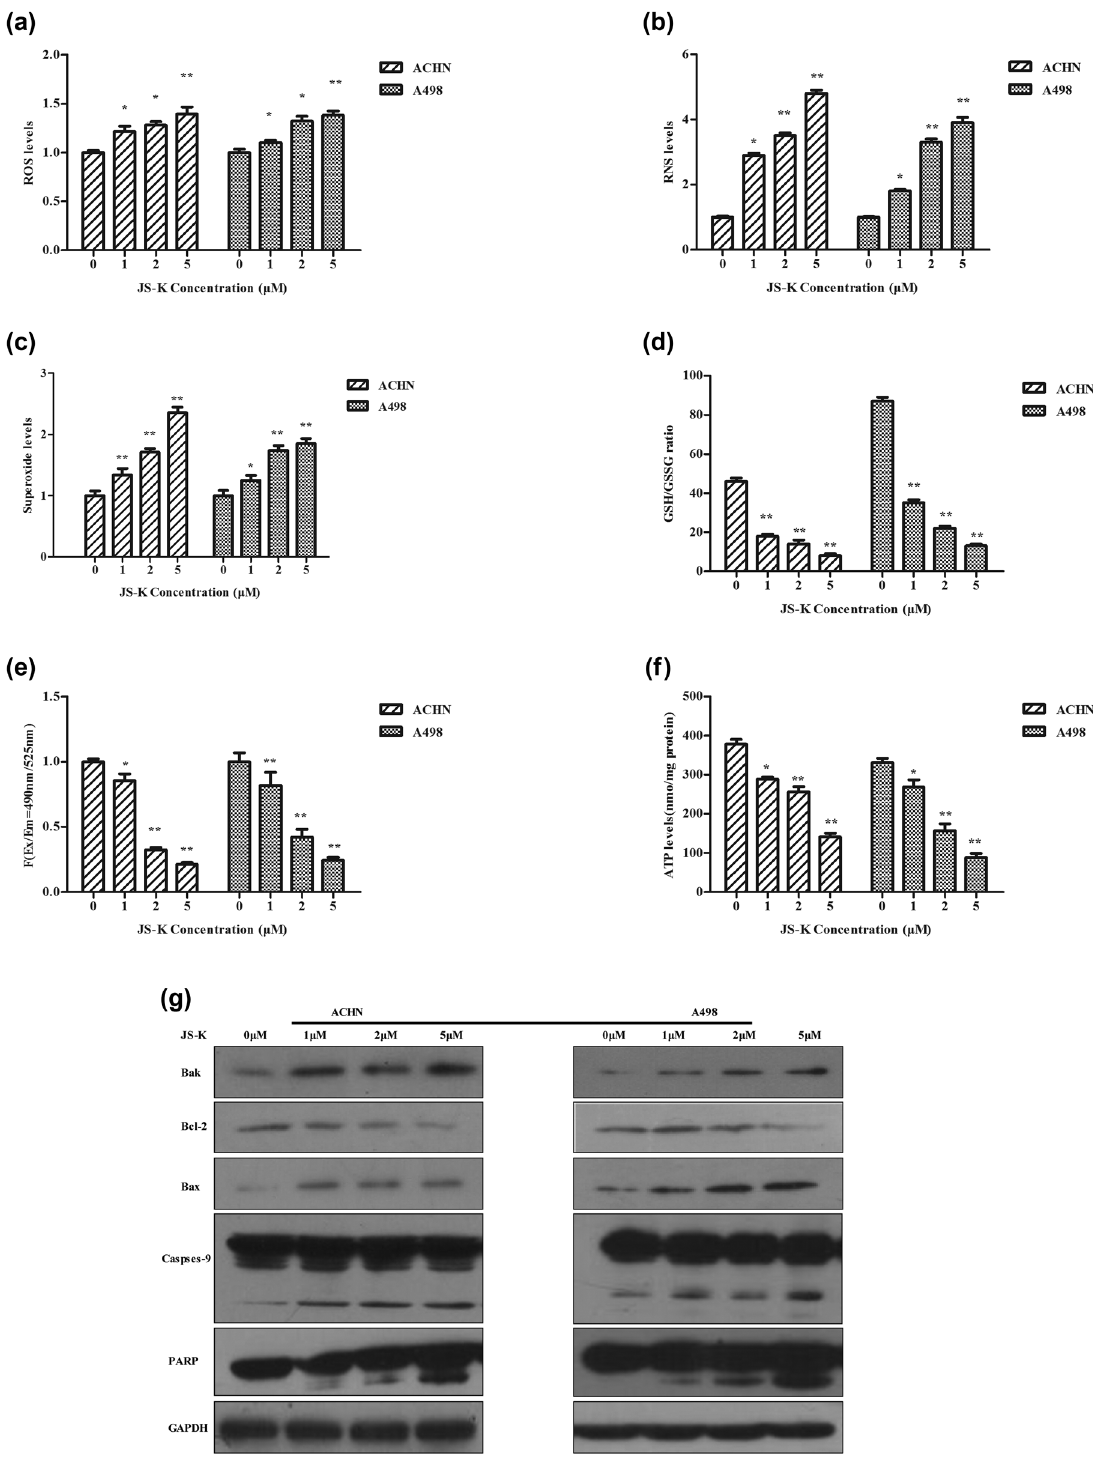
Figure 4: E ff ect of JS - K on ROS, RNS, mitochondrial membrane potential, GSH/GSSG ratio, ATP production, and apoptotic - related proteins in renal carcinoma cells. Treatment of JS - K renal carcinoma cells ( 0, 1, 2, and 5 μ M ) for 360 min, and then detection of intracellular maximum ROS ( a ) , RNS ( b ) , superoxide ( c ) , and GSH/GSSG ratio ( d ) levels. Upon 360 min of JS - K treatment, measurements were made for mito - chondrial membrane potential ( e ) and ATP output ( f ) . Western blot was used to identify concentrations of apoptotic - related proteins such as Bak, Bax, and PARP after cells were treated with JS - K ( 0, 1, 2, and 5 μ M ) for 24 h ( g ) . For at least three separate assays, fi ndings are reported as mean ±